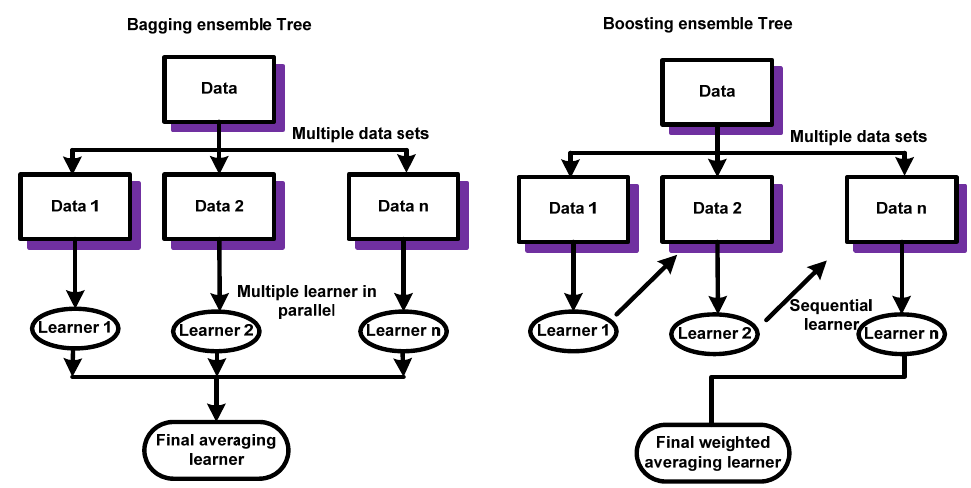
Figure 5. Difference between bagging and boosting models.